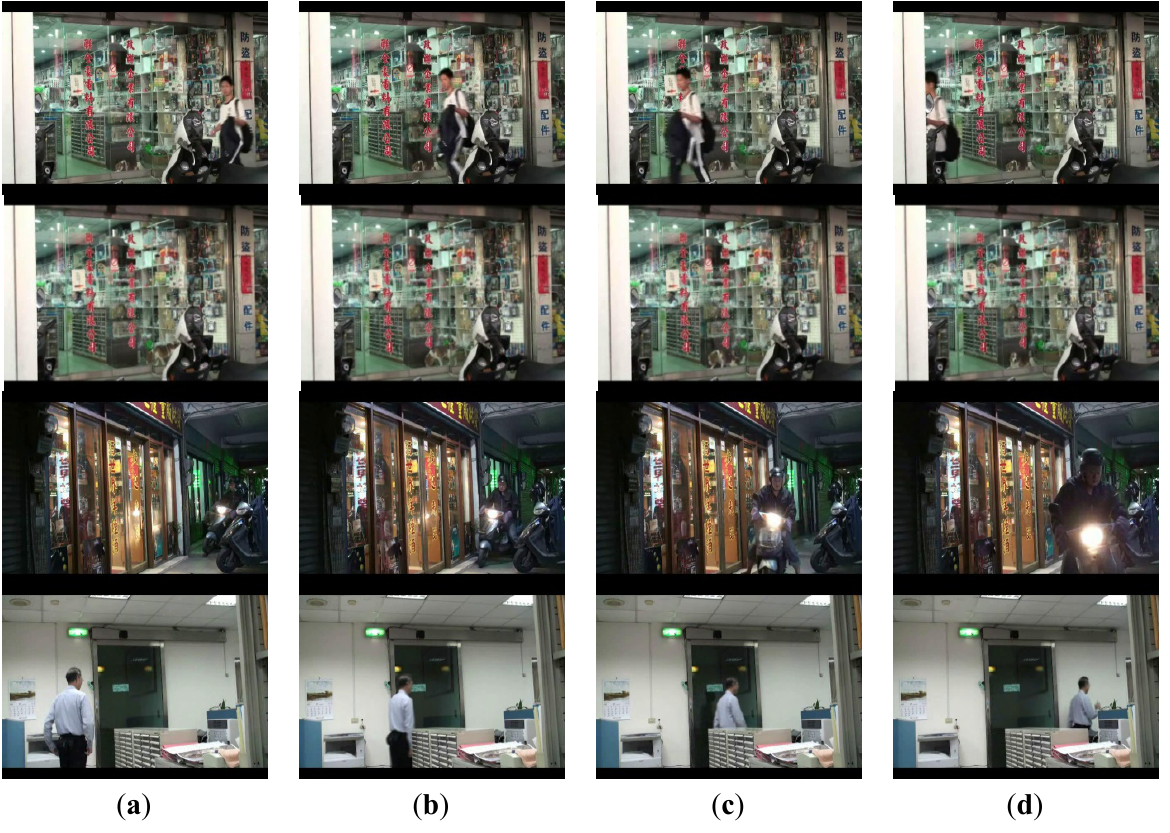
Figure 10. Illustrations of correct activation rejection at the same places. The first and second rows show the cases of a human passing by and stay of a lying dog, respectively. The third and fourth rows show the passing by conditions of a motorcycle and a human respectively.